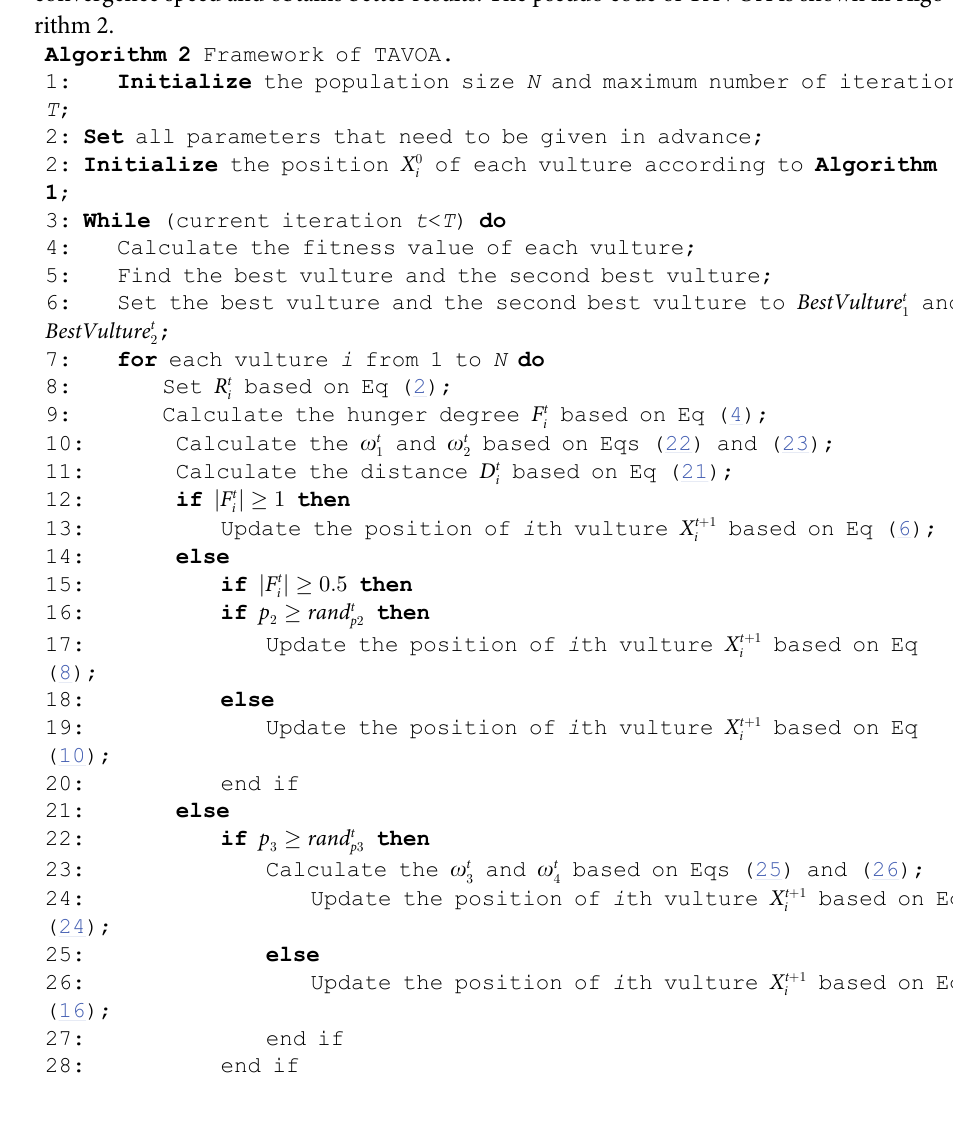
Algorithm 2 Framework of